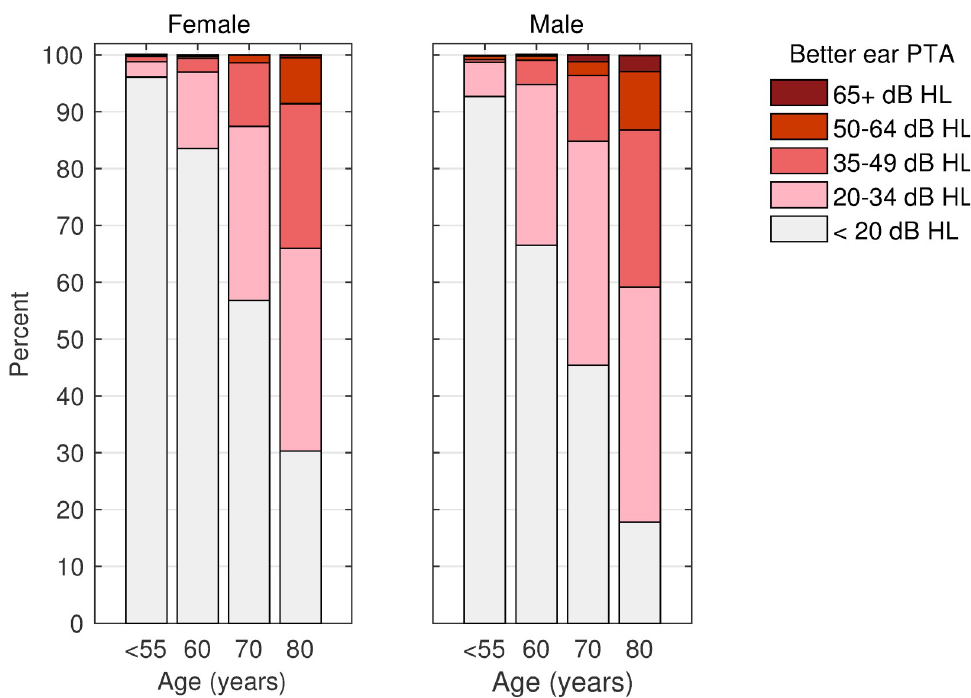
Fig 1. Degree of hearing loss. Hearing loss according to the GBD classification [13] in females (left panel) and males (right panel). Categories defining severe to profound HI and profound HI were combined. Sample weights applied to adjust professional education to population statistics.